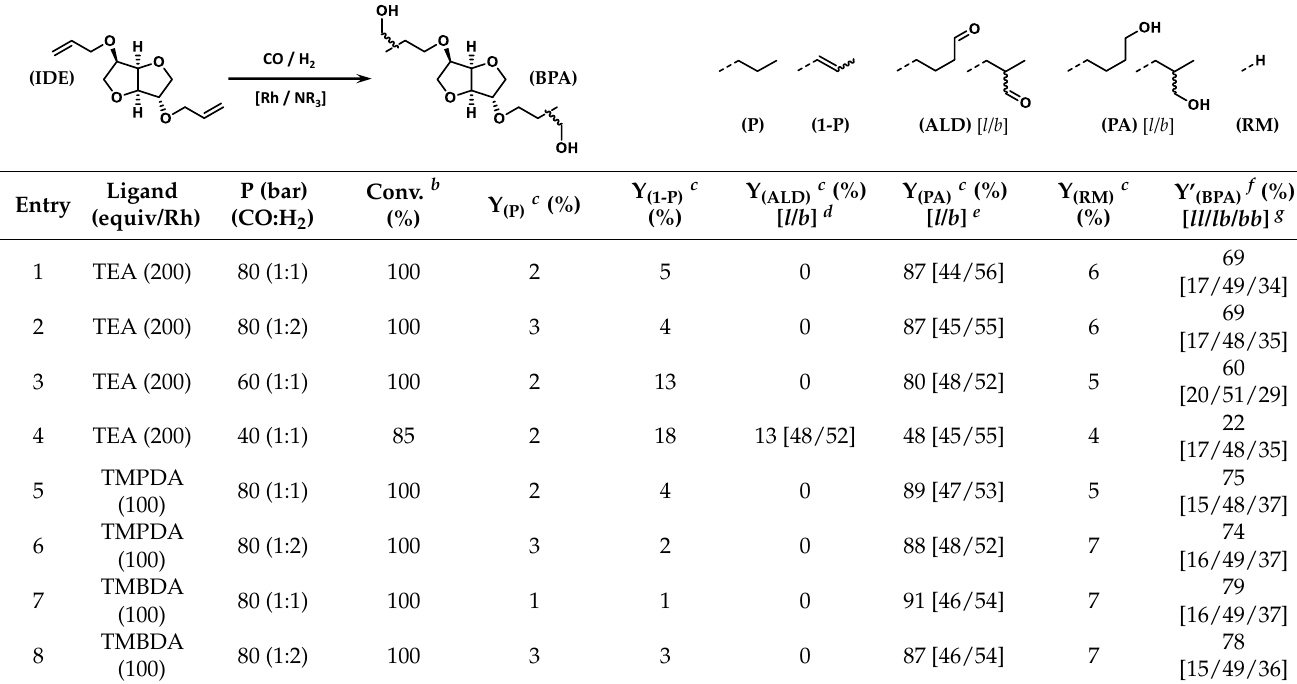
Table 3. Influence of syngas pressure and composition on IDE hydrohydroxymethylation a . Table 1. Influence of the TEA amount on IDE hydrohydroxymethylation